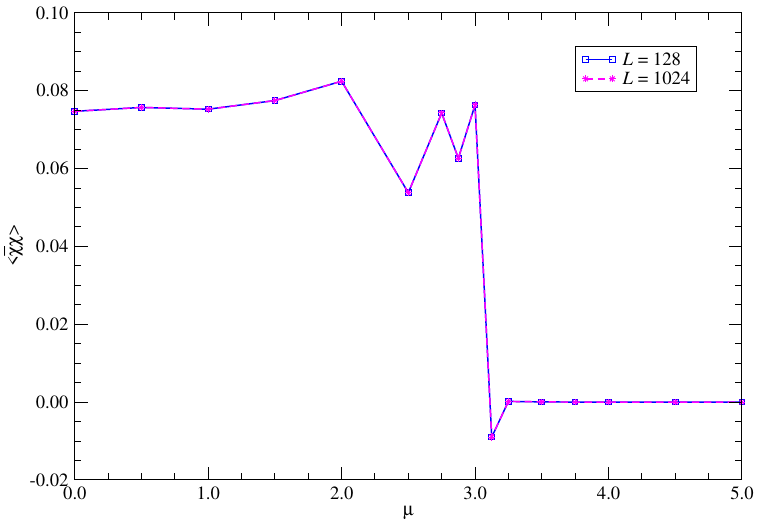
Figure 7 . Chiral condensate extrapolated in the chiral limit as a function of µ with D = 55 on 128 4 and 1024 4 lattices.